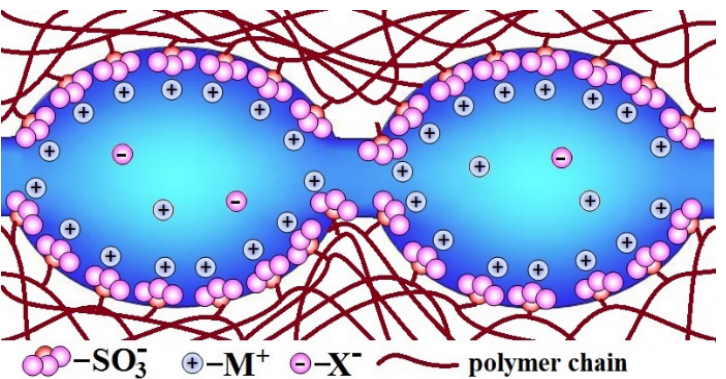
Figure 5. Structure of pores and channels in the ion-exchange membranes (adapted from [123]). Reproduced with permission from [123]. Springer, 2013.